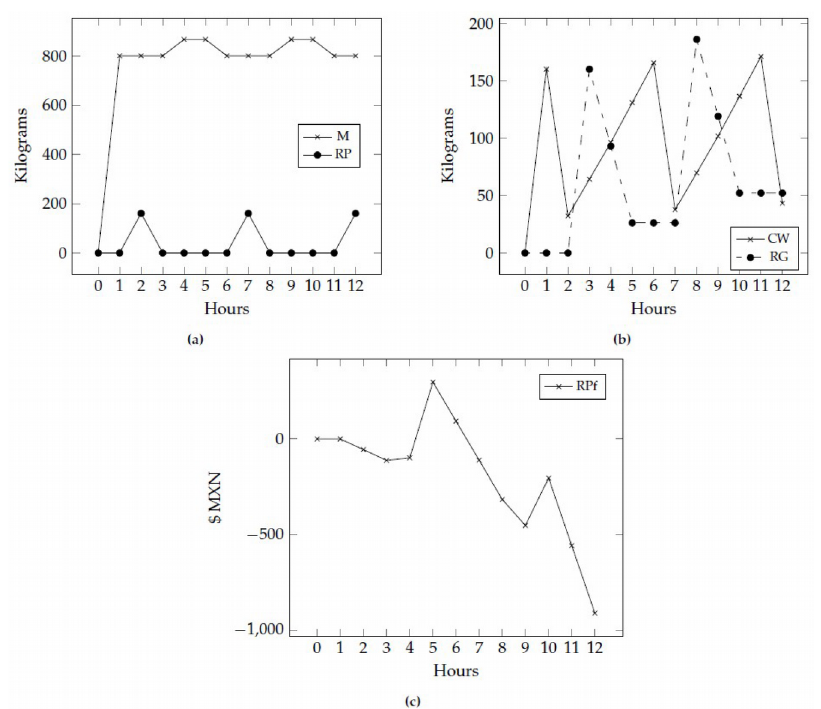
Figure 5. Performance of main variables in the hybrid simulation model: (a)